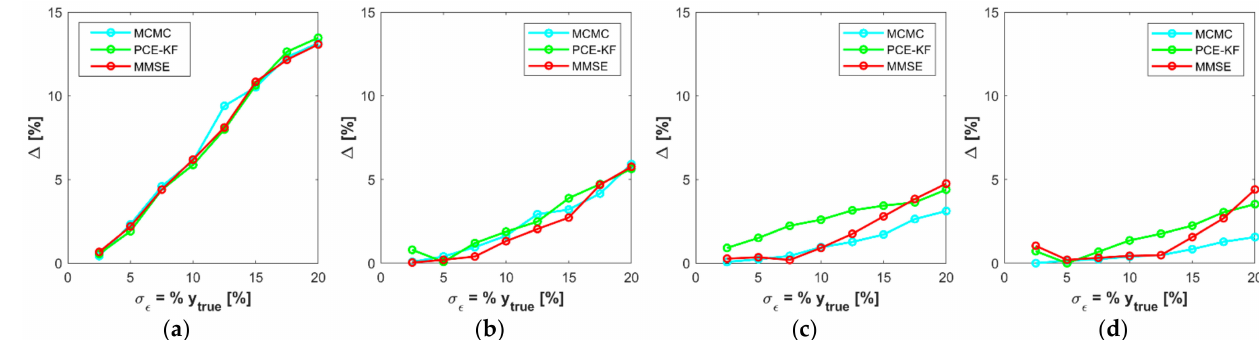
Figure 4. Percentage deviation ∆ % in the updating according to different methods, variation with measurement error σ ε considering q true = µ + σ : ( a ) Model 1, ( b ) Model 2a, ( c ) Model 2b and ( d ) Model 3. Results are compared for the MCMC method (in cyan), the PCE-KF method (in green) and the NL-MMSE method (in red).